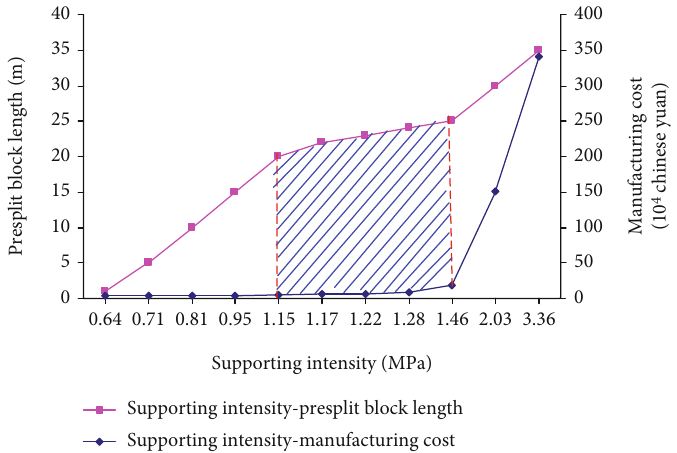
Figure 8: Relationship between supporting strength and length of blasting presplitting block and cost of